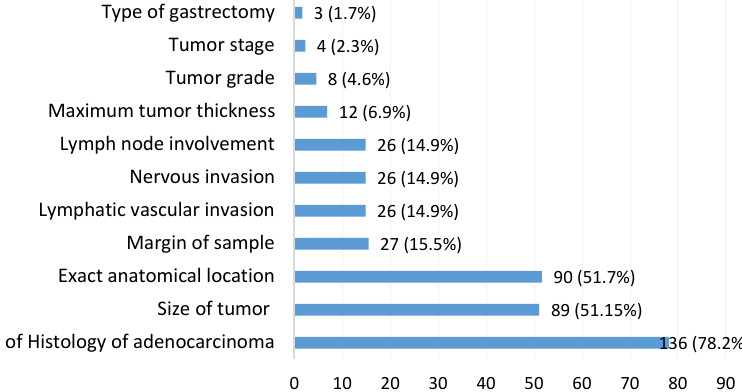
Figure 1. Prevalence of Reporting the Studied Variables.